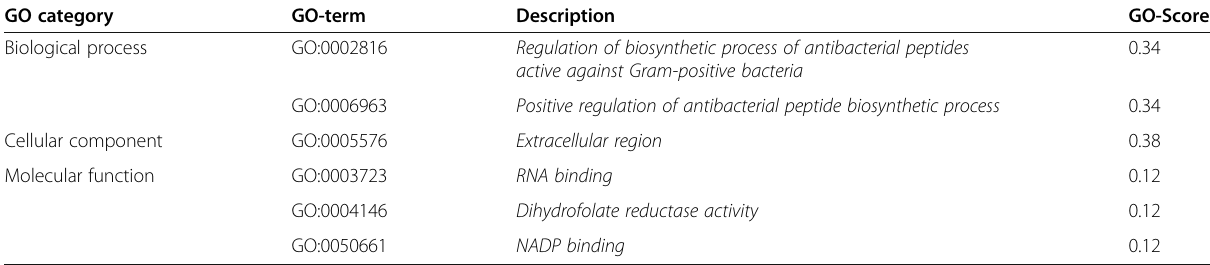
Table 2 Consensus GO-term annotations of On -Def by the I-TASSER suite. The GO-score associated with each prediction is defined as the average weight of the GO term